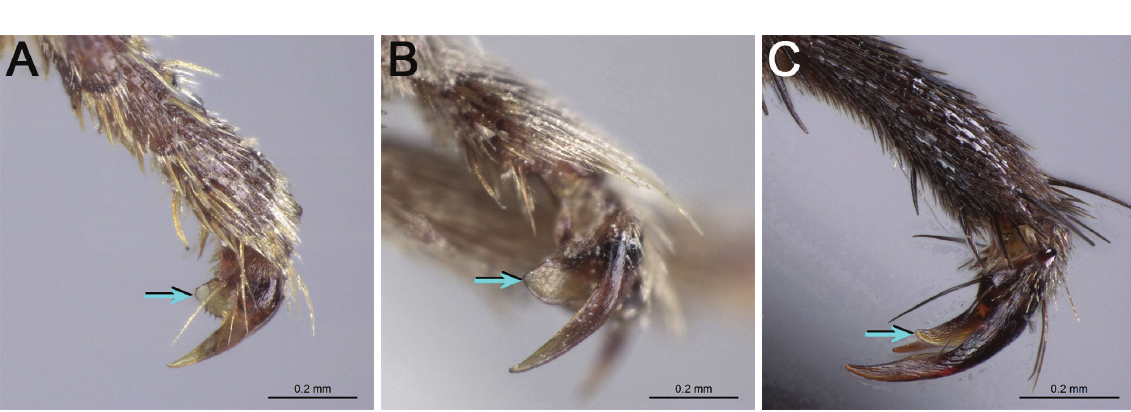
Fig. 2. Metadistitarsus of male, lateral view. A . Brachymelecta californica (Cresson, 1878) (photo of Melecta ? mucida holotype (ANSP 2294), herein synonymized under B. californica ), in which the inner ramus (blue arrow) of each tarsal claw is broad, lobe-like, and thus does not resemble the outer ramus. B . B. californica (photo of M. californica lectotype (ANSP 2292)), in which the inner ramus (blue arrow) of each tarsal claw is broad, lobe-like, and thus does not resemble the outer ramus. C . Melecta thoracica Cresson, 1875 (BOLD sample ID: LRBBC1476; PCYU LRB09-3186), in which the inner ramus (blue arrow) of each tarsal claw is narrow, pointed, and thus resembles the outer